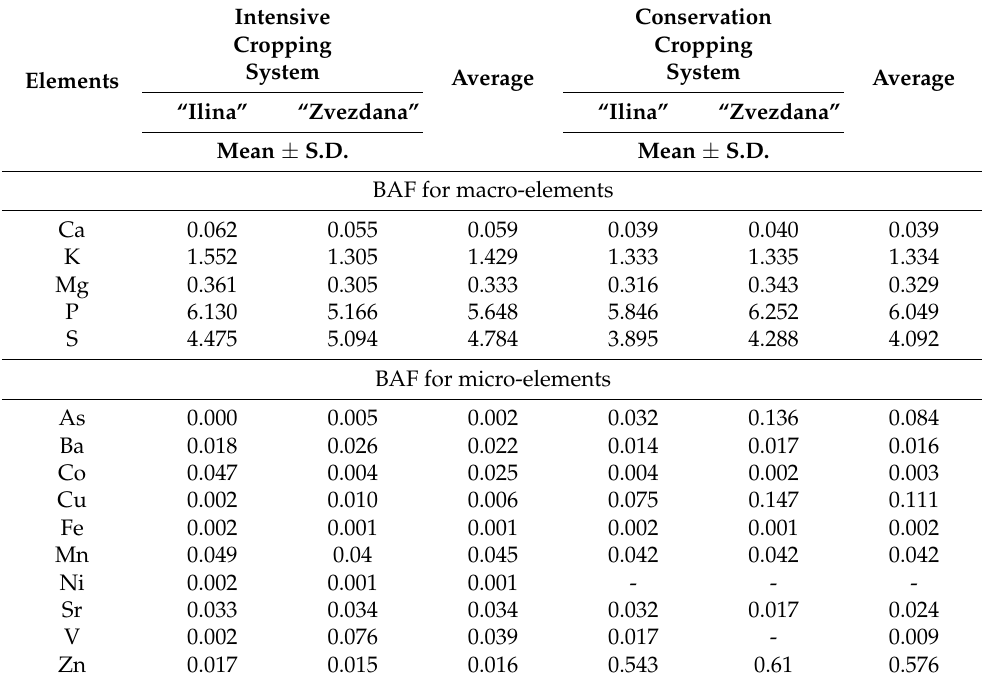
Table 4. The bioaccumulation factor of the macro- and microelements in ICS and CCS cropping systems.